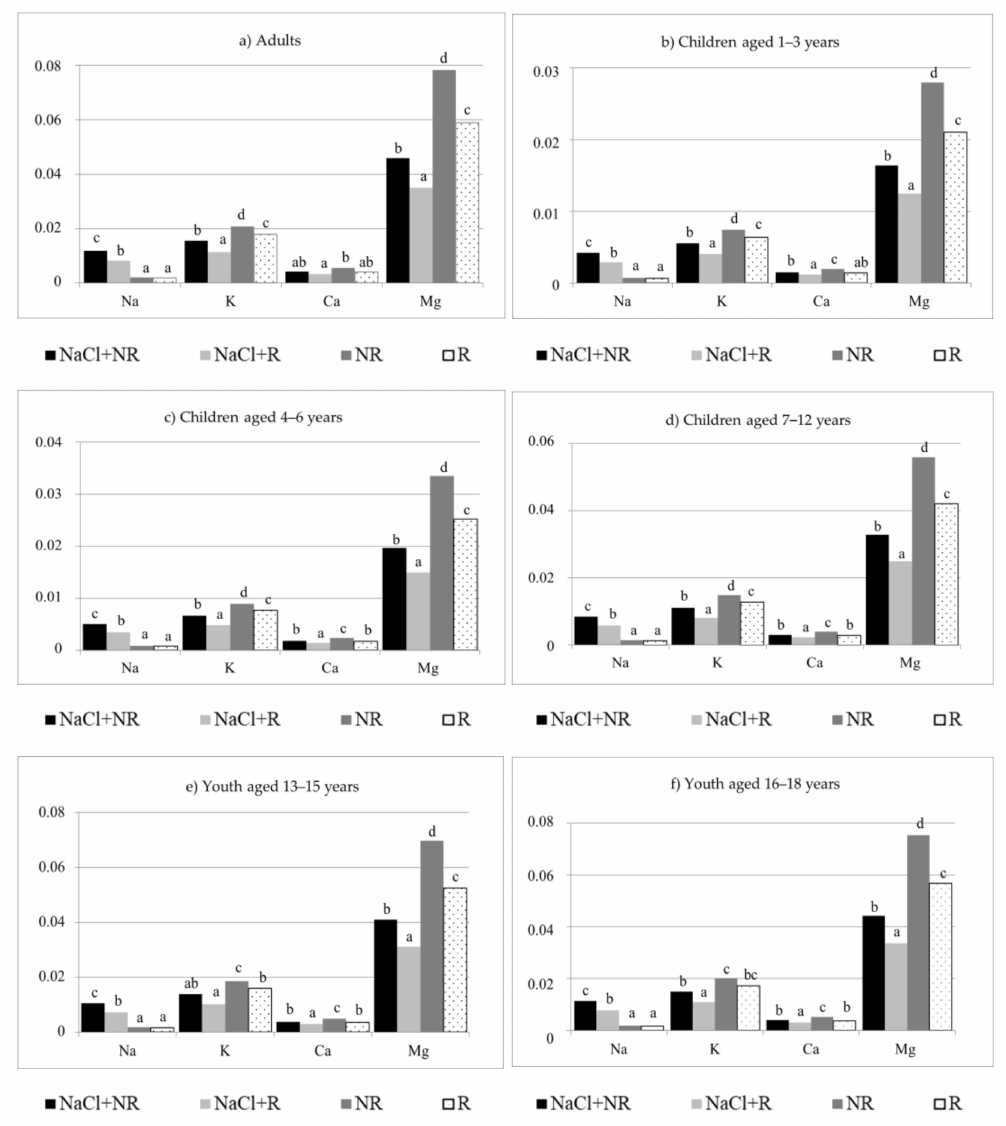
Figure 3. Intake of Na, K, Ca, and Mg with analysed pasta per portion, cooked, g. Portion size: ( a ) Adults 140 g [24], ( b )